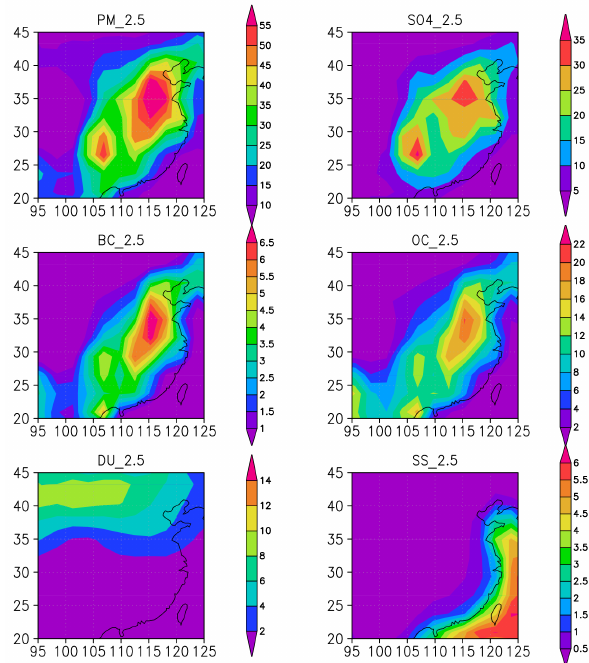
Fig. 4. Total surface PM 2 . 5 in China and contributions to it from different aerosol species (four-year average (2006–2009), in units µgm − 3